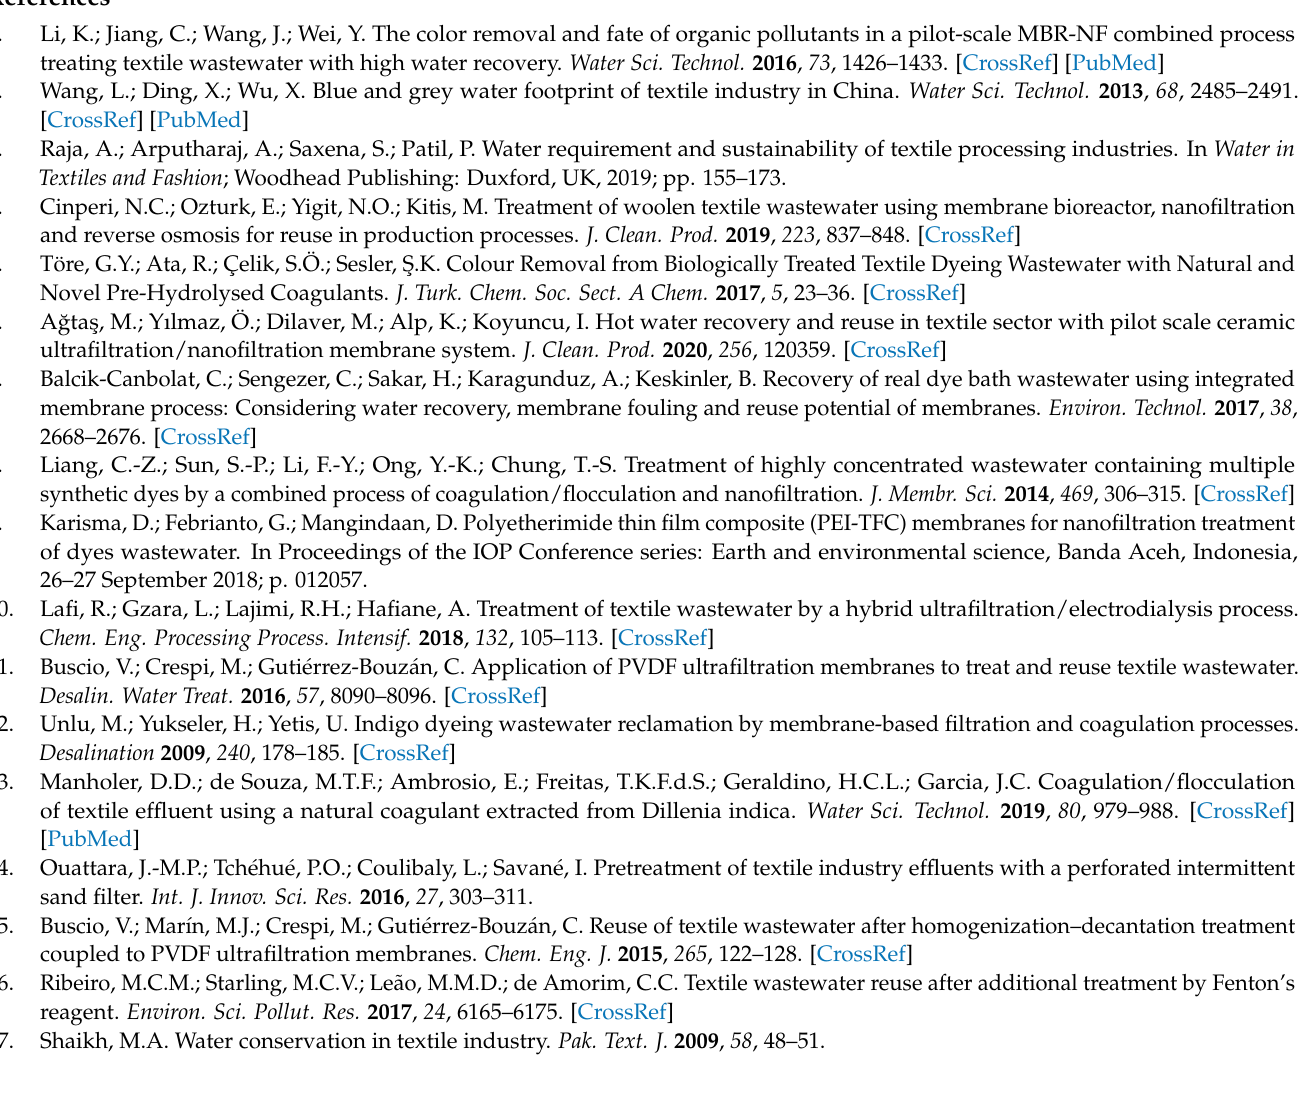
Table S2: Results of jar test experiments with FeCl 3 /MagnaFloc